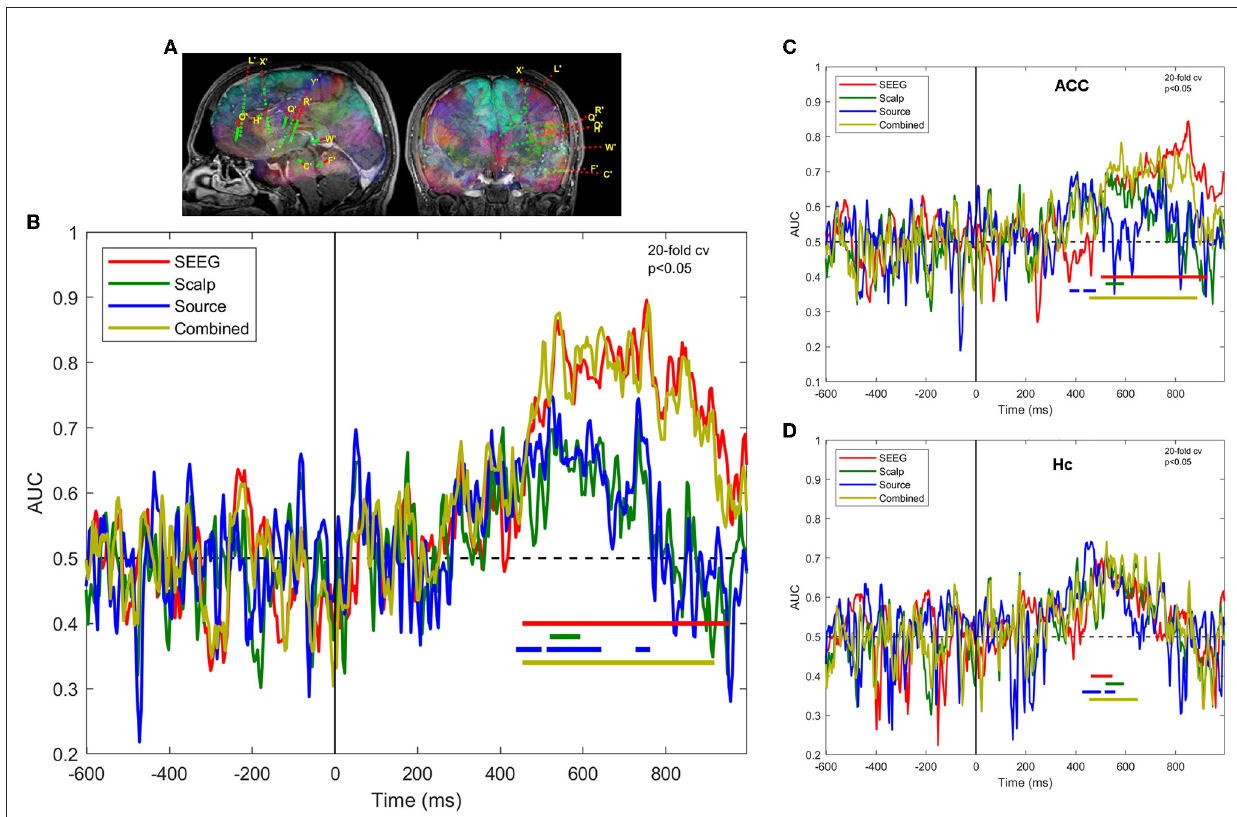
FIGURE3 Task decoding performance is expressed as the area under curve of the receiver operating characteristic of the classifier for SEEG, scalp, and source signals in patient 3. (A) SEEG electrode locations in the left hemisphere; (B) ROC-AUC for sensors of different types, as well as for combined scalp and SEEG; (C) same as (B) , but for the contacts located in the anterior cingulate cortex; (D) same as (B) , but for contacts located in the